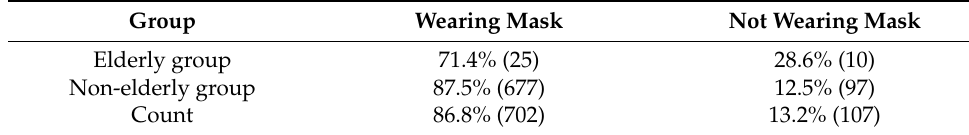
Table 4. A cross-tabulation analysis of two different age groups in wearing masks.